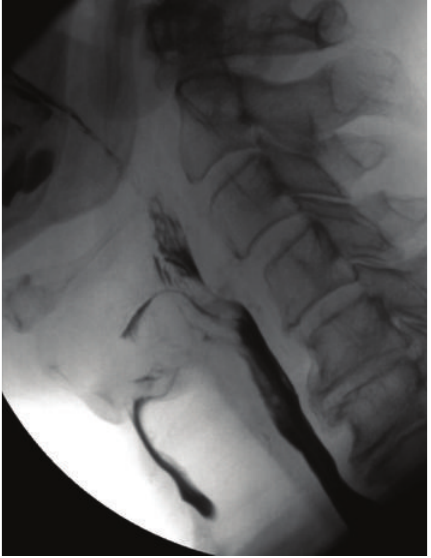
Figure 5: Spot view from a fluoroscopic examination in a 76-year- old patient after stroke showing